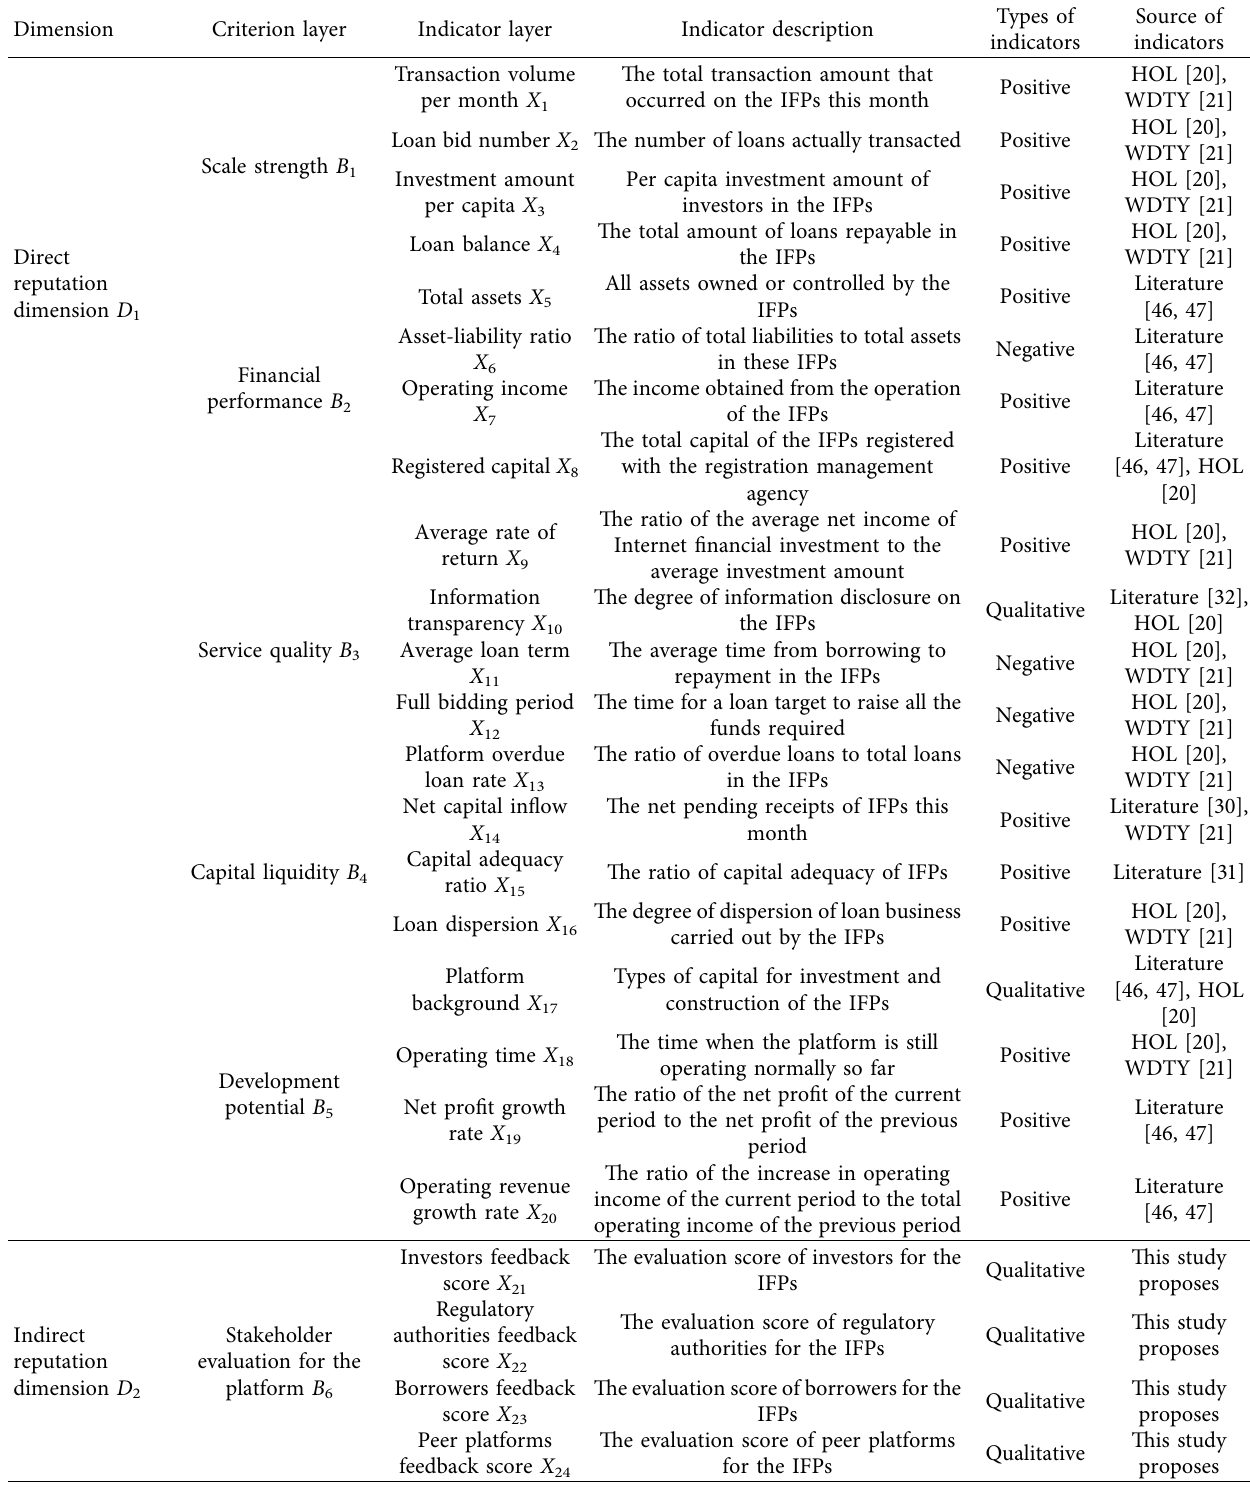
Table 1: The reputation evaluation indicator system of